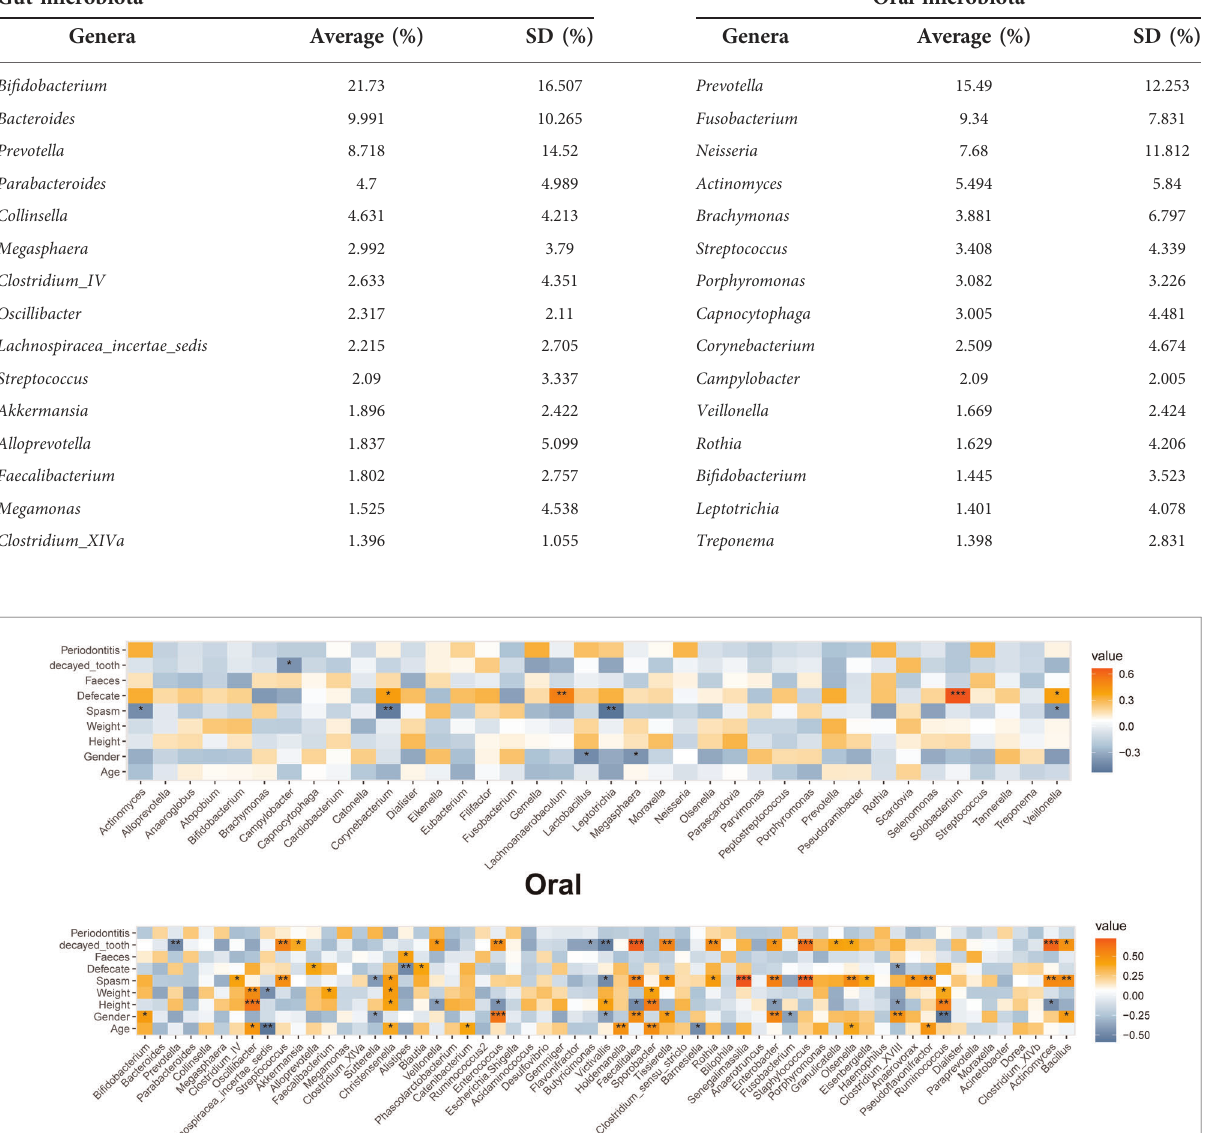
TABLE 2 Top 15 abundant genera in oral and gut microbiota.